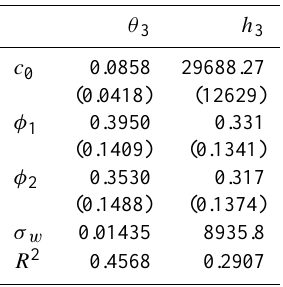
Table 2. Parameter estimates and comparison of SAR(1) model for the series examined and goodness of fit index R 2 ; in parenthesis the standard deviation of the estimates.